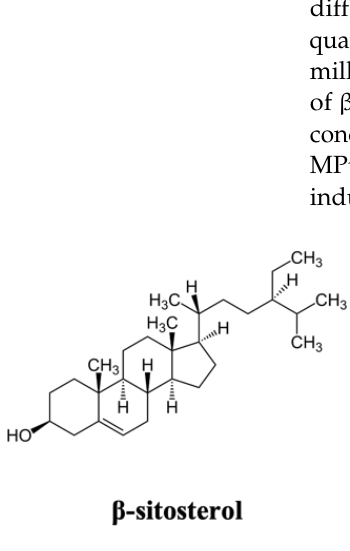
Figure 2. Structure of main dietary plant sterols.